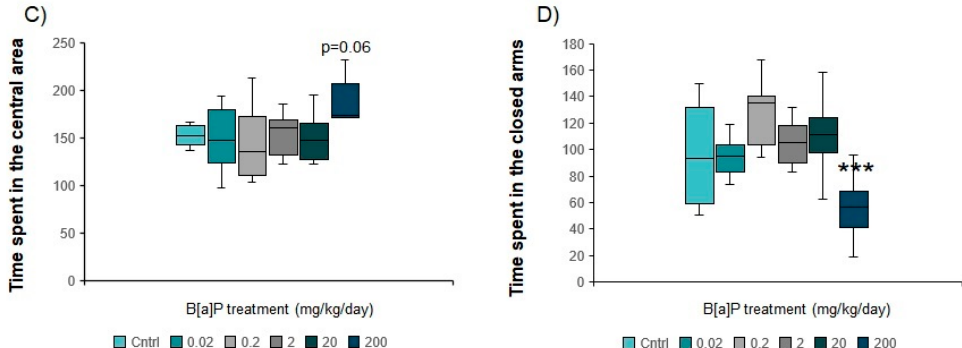
Figure 6. Evaluation of anxiety-related behaviour of B[a]P-exposed mice (oral gavage: 0.02 to 200 mg/kg, 10 consecutive days) in the EPM. ( A ): total number of visited arms, ( B ): Time (s) spent in the open arms, ( C ): Time (s) spent in the square central zone, ( D ): Time (s) spent in the closed arms. Data from 10 mice per group are expressed as the median (central line); boxplot represents the 1st (25%) and 3rd (75%) quartiles; minimum and maximum values observed are represented by error bars. *** p < 0.001 (MW-U test modified for multiple comparisons).